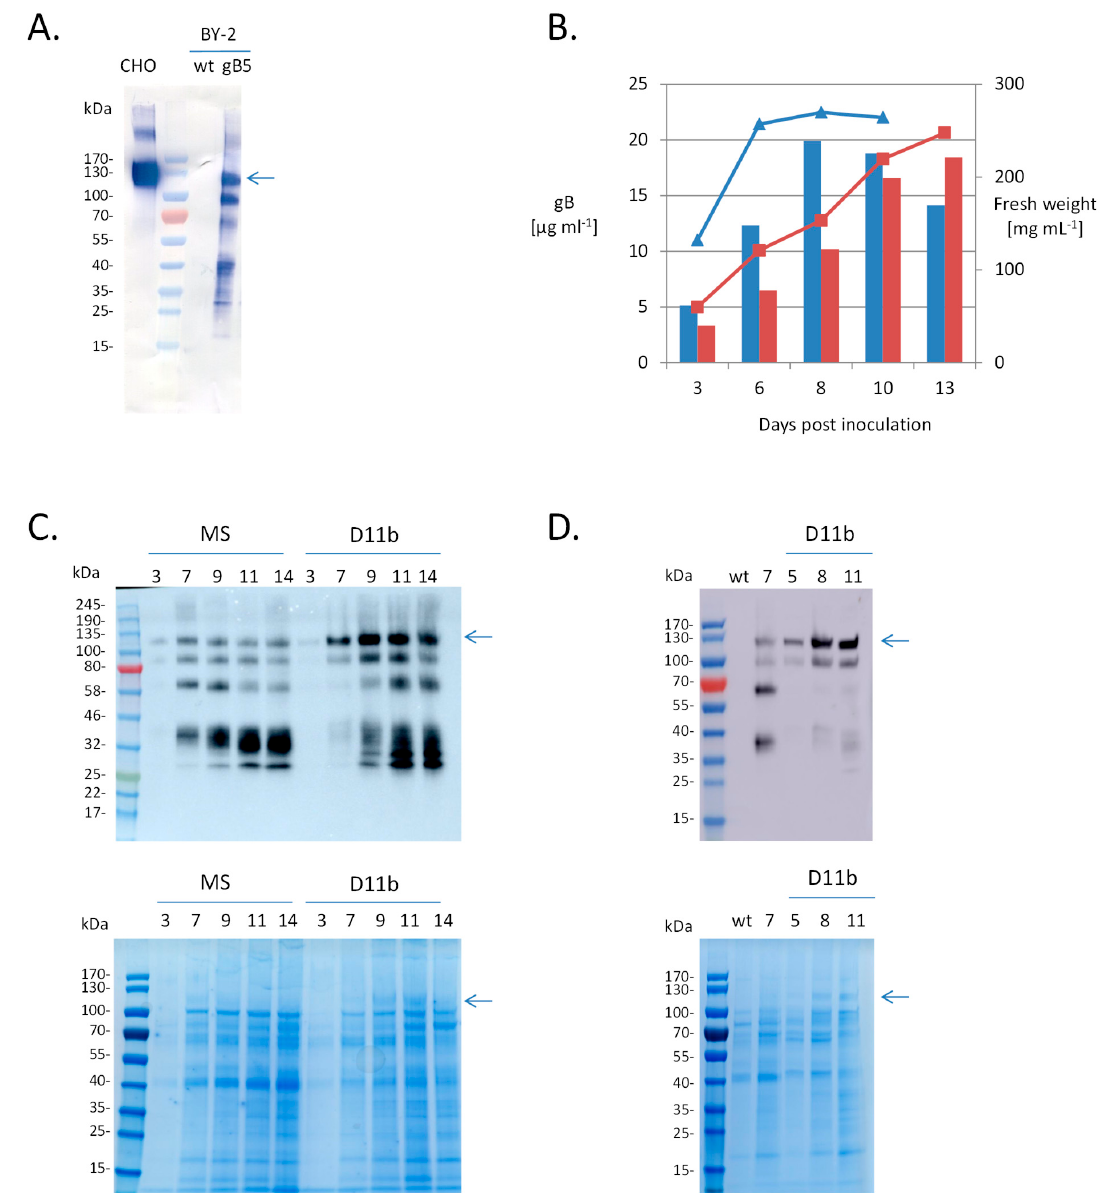
Figure 1. Expression and secretion level of glycoprotein B (gB) ectodomain in Bright Yellow-2 (BY-2) cells. ( A ) Western blotting analysis of gB. CHO, purified gB produced in Chinese hamster ovary (CHO) cells (1.2 µ g); wt, extracellular medium from BY-2 wild type (40 µ L); gB5, extracellular medium from line gB5 (40 µ L). Western blotting using anti-gB antibodies was performed as indicated in Materials and Methods. ( B ) Kinetics of cell growth (fresh weight-lines) and gB accumulation in culture medium (quantified by ELISA-bars) of line gB5 grown in MS (blue) or D11b medium (red). ( C ) Analysis of extracellular medium of line gB5 grown in MS or D11b medium by Western Blotting (10 µ L) and Coomassie-blue stained SDS-PAGE (40 µ L). Samples of extracellular medium from line gB5 were collected 3, 7, 9, 11 and 14 days after inoculation. Western blotting using anti-gB antibodies was performed as indicated in Materials and Methods. ( D ) Analysis of extracellular medium of line gB16 grown in MS or D11b medium by Western Blotting (50 µ L) and Coomassie-blue stained SDS-PAGE (50 µ L). Samples of extracellular medium were collected 7 (MS), or 5, 8 and 11 (D11b) days after inoculation. Western blotting using anti-gB antibodies was performed as indicated in Materials and Methods.